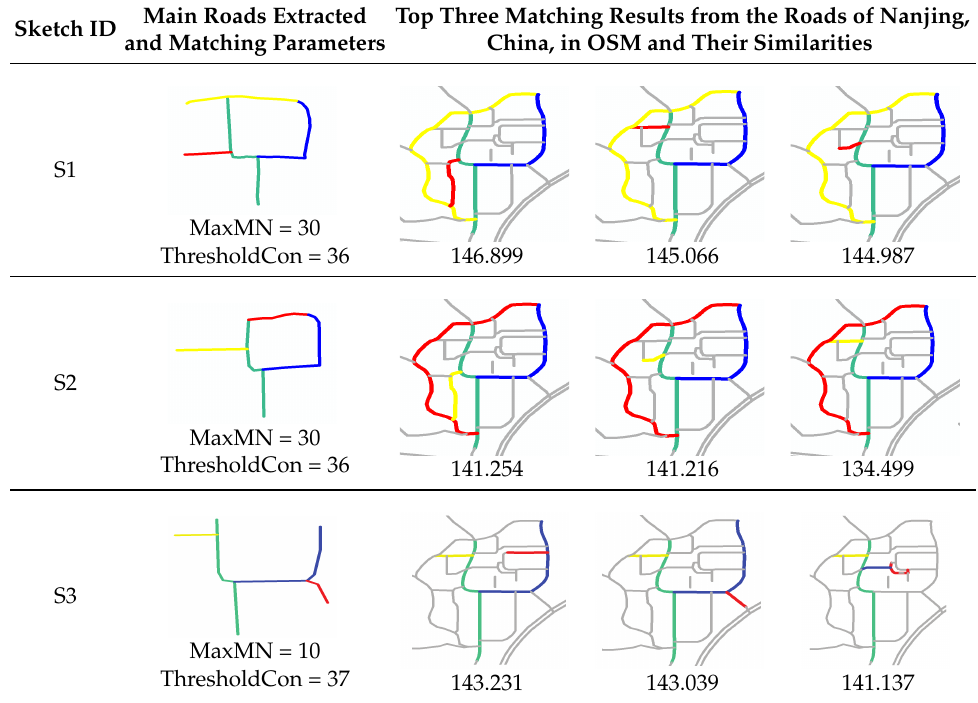
Table 5. Matching results for all sketches. FMP is assigned to the green road. MaxMN is the maximum number of matched individual roads from OSM involved in the process of composite road matching. ThresholdCon is the threshold of the direction difference for computing CD of the green